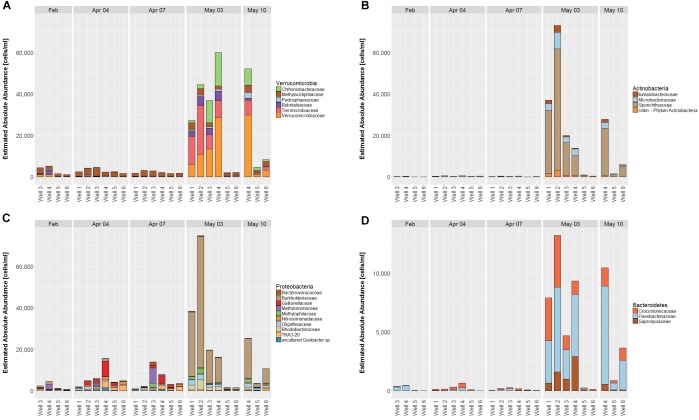
Estimated absolute abundance on family levels (cut-off value 0.5%) for the Phyla Verrucomicrobia (A), Actinobacteria (B), Proteobacteria (C), and Bacteroidetes (D). Due to lower abundance, y-axis scaling is smaller for D than for A–C.